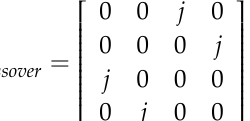
Figure 5. Simulated amplitudes of S-parameters of the crossover.